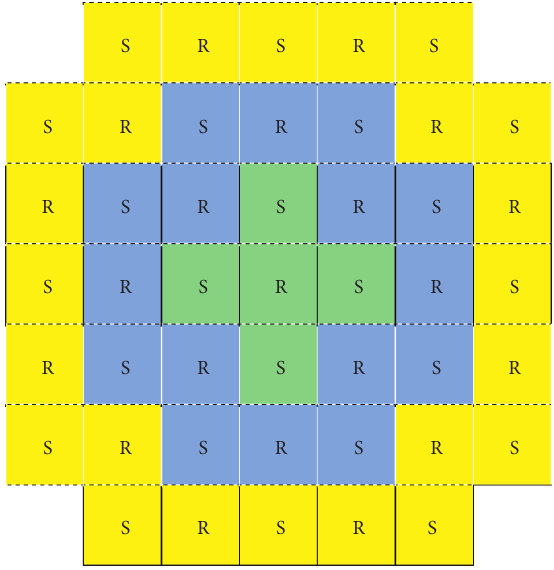
Figure 4: Locations of the CEAs in the active core zone.